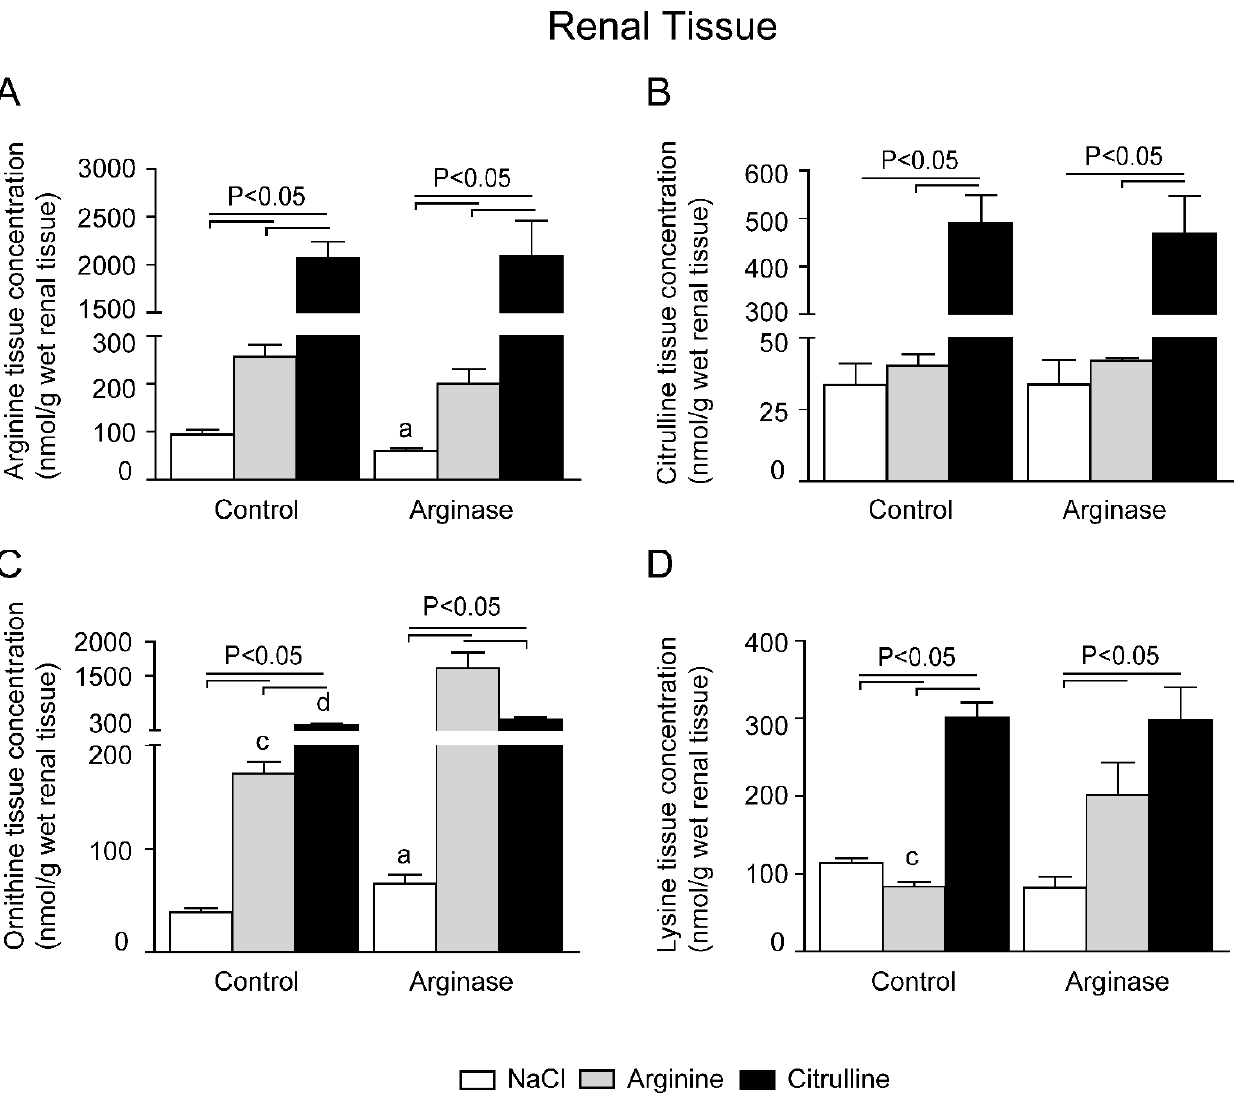
Figure 6. Effect of L -arginine or L -citrulline supplementation on renal tissue amino acid concentrations in control and arginase-treated mice. Renal tissue concentrations during basal and arginase-treated conditions of ( A ) arginine, ( B ) citrulline, ( C ) ornithine and ( D ) lysine were measured with HPLC. Tissue concentrations are displayed as nmol/g wet